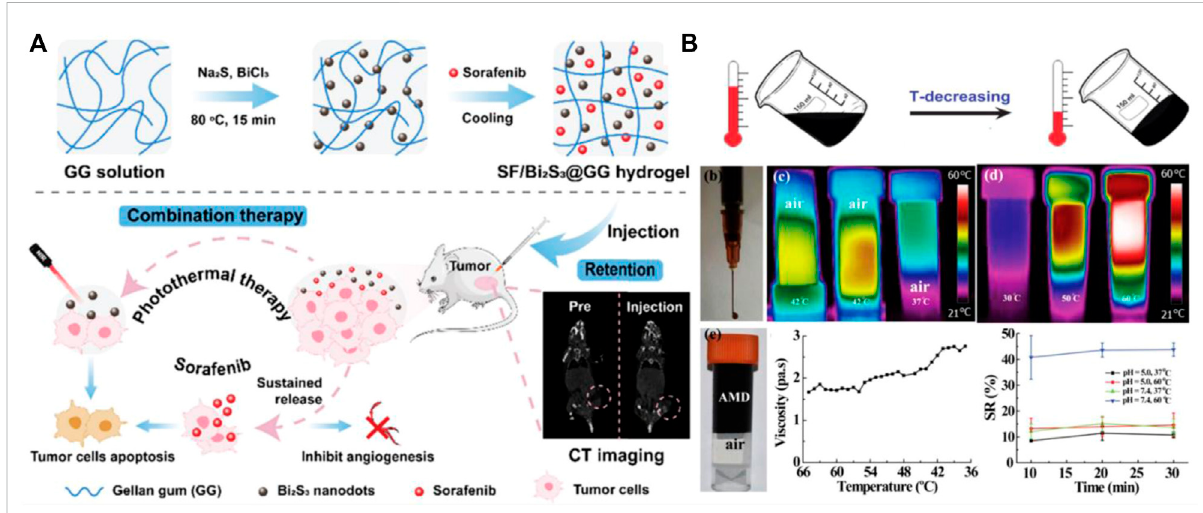
FIGURE 3 (A) Preparation of SF/ Bi2S3@GG photothermal nanohydrogel and its application in tumor therapy. Reproduced from ref. 83 with permission from 2021 Royal Society of Chemistry. (B) The formation principle of AMD hydrogel and its photothermal performance test. Reproduced from ref. 81 with permission from 2017 Published by Elsevier Ltd.